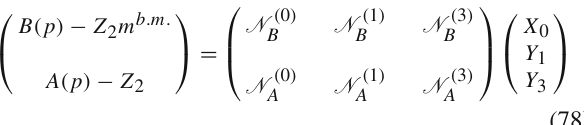
occur for those functions calculated only for q ∈ [ 0 , Λ/ 2 ] , compared to the version of the linear system were they are computed in the range q ∈ [ 0 , Λ ] . In the first case, i.e. for the solutions computed only for q ∈ [ 0 , Λ/ 2 ] , there appears a discontinuity at q = Λ/ 2 (recall that the form factors are set to zero for momenta above Λ/ 2) but for smaller q the form factors of all versions of the linear system are indistin- guishable. On Fig. 18 the residuum squared of the scalar (top) and vector (bottom) components of the gap equation are shown against the norm of various form factors. Smaller values of (cid:19) are associated to solutions with larger norms and appear at the right side of the plots, while larger values of (cid:19) are asso- ciated to solutions with smaller norms that show up on the left side of the plots. As shown on the figure, the residuum for both equations has a stronger dependence on (cid:19) and can take quite small values. For the solutions featured in the plot, the smallest residuum squared reaches values of the order of 10 − 5 for the scalar equation and 10 − 4 for its vector com- ponent. Similar values for the minimum residuum were also observed for the solutions computed using the perturbative estimation of X 0 . On Fig. 18 we identify four solutions associated to an (cid:19) around its optimal value and whose characteristics are